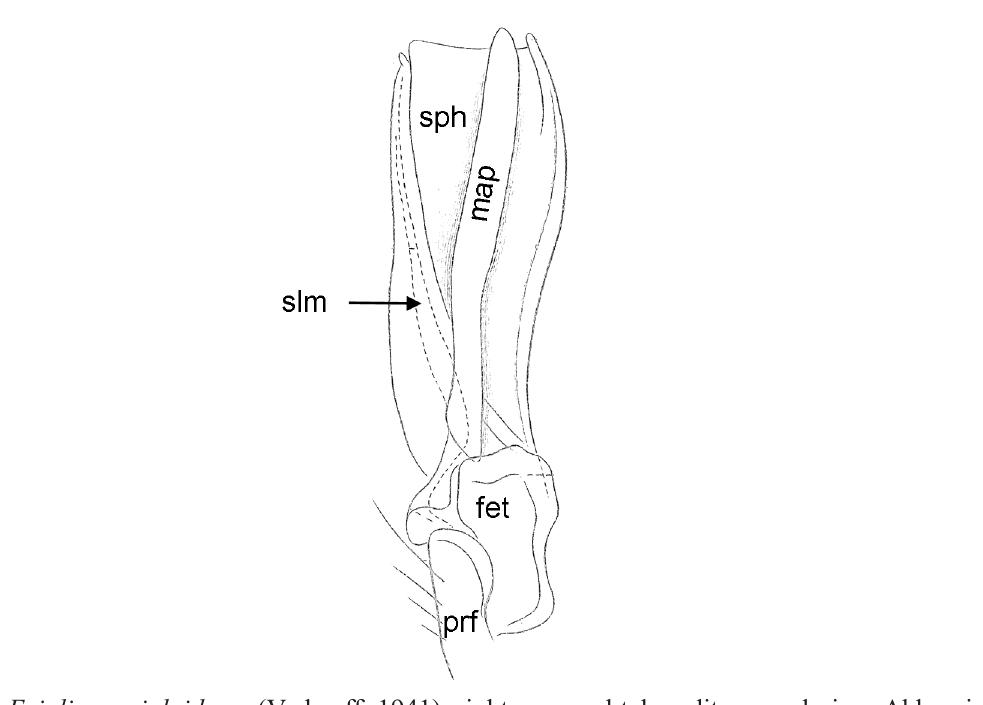
Fig. 32. Eviulisoma iuloideum (Verhoeff, 1941), right gonopod telopodite, mesal view. Abbreviations: fet = ʻfemoriteʼ; map = mesal acropodital process; prf = prefemoral part; slm = solenomere